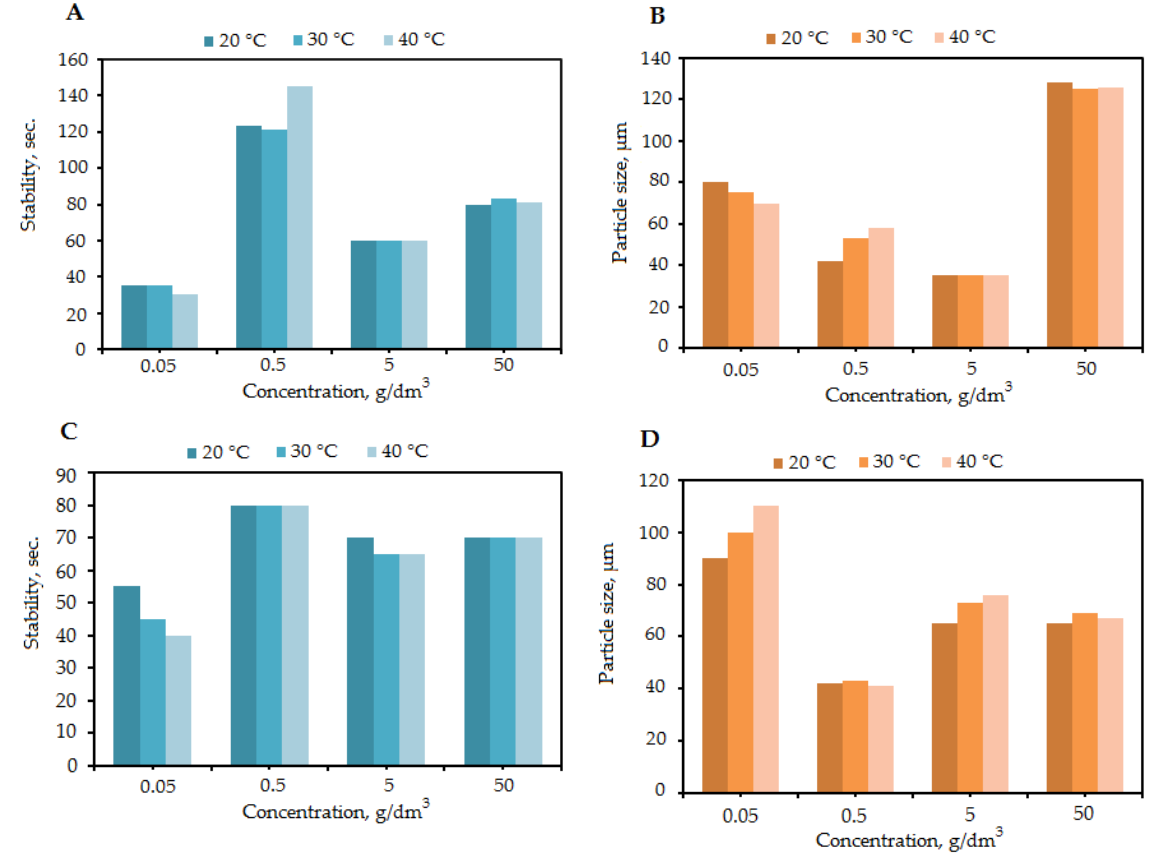
Figure 5. Influence of frother solution concentration on stability and size of WAME: ( A , B )—reagent T-92; ( C , D )—reagent BTF-163.